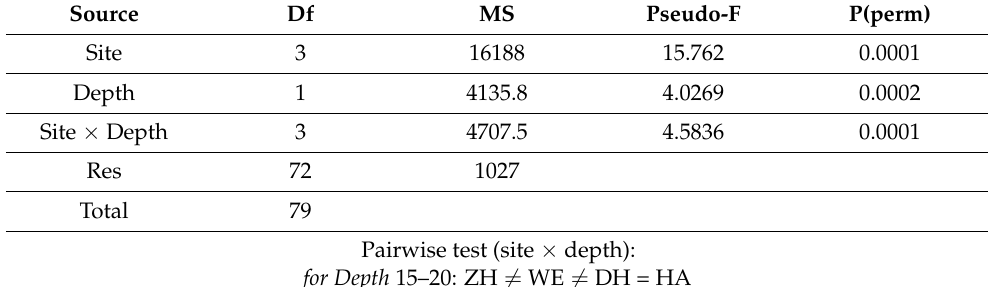
Table 3. Permutational multivariate analysis of variance (PERMANOVA) performed on the dataset. Bray–Curtis resemblance matrix based on percentage of covering. Permutation N: 9999.